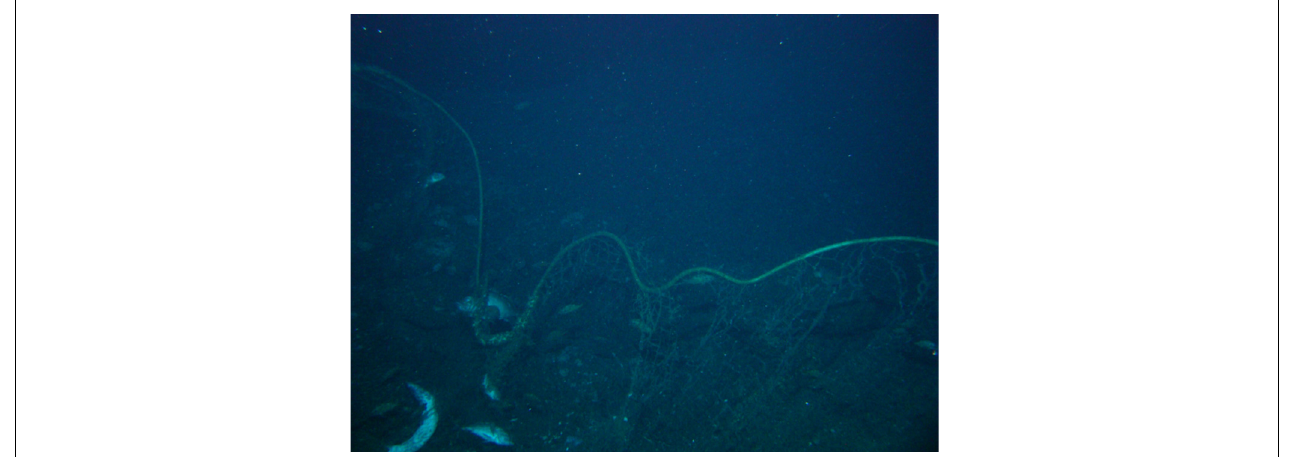
FIGURE 5 | Photo demonstrating fishing pressure example showing a discarded gill-net that has caught fresh fish, located near the Hafgufa hydrothermal vent field.